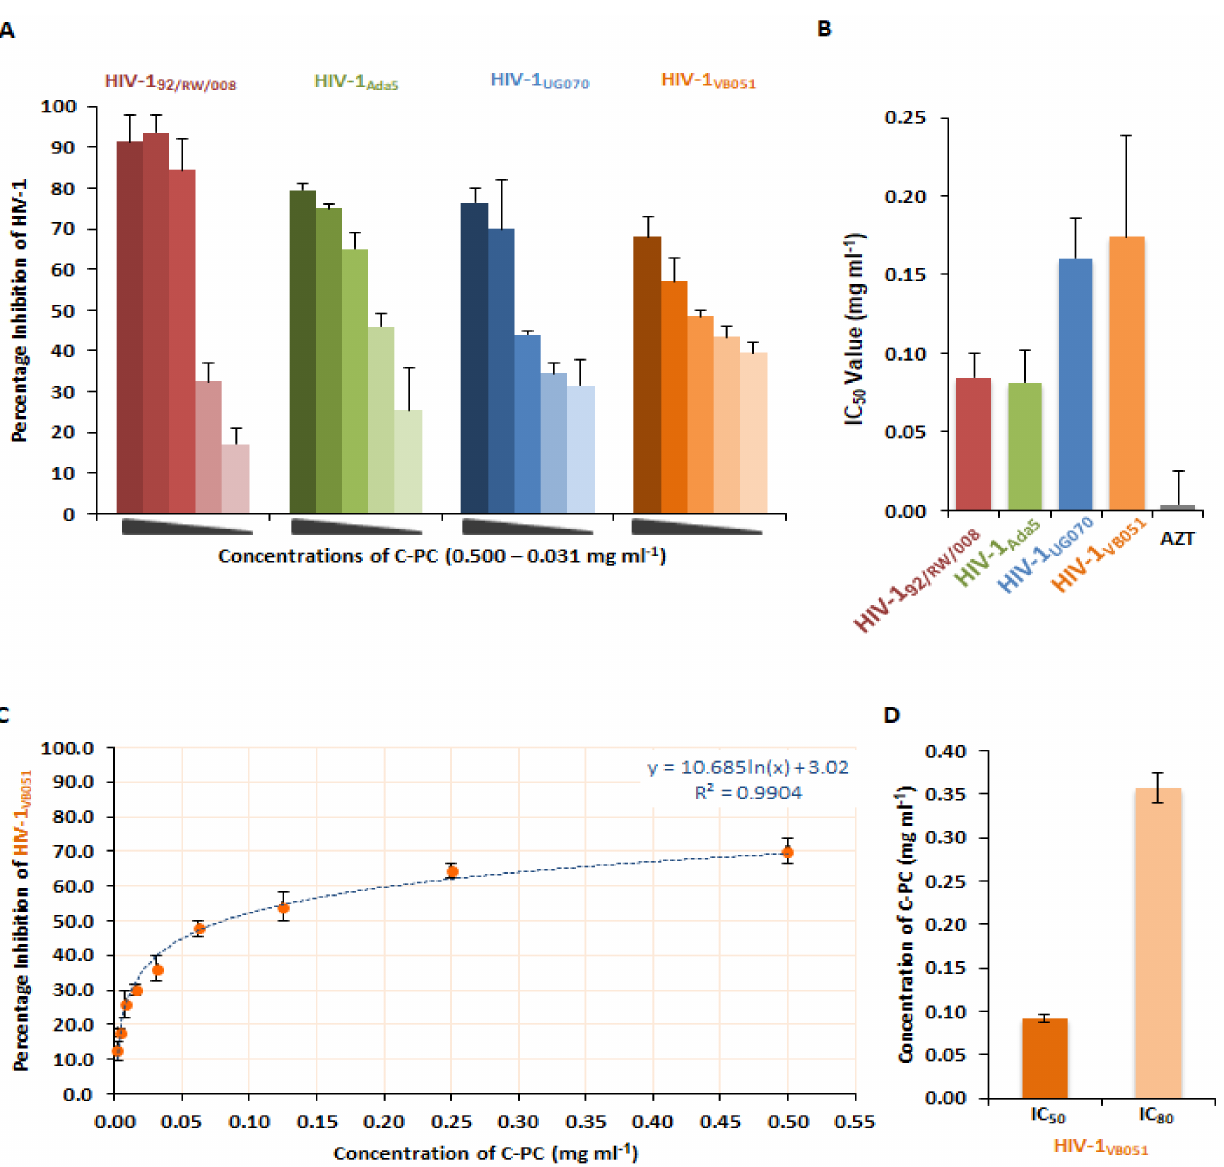
Figure 2. C-PC inhibits HIV-1 replication. ( A ) Percentage inhibition of four different subtypes of HIV-1 replication in the presence of C-PC (0.500–0.0312 mg/mL) in TZM-bl cells. ( B ) The IC 50 values for HIV-1 92/RW/008 , HIV-1 Ada5 , HIV-1 UG070 , and HIV-1 VB051 in TZM-bl. ( C ) Dose-dependent activity of C-PC in the PBMCs infected with HIV-1 VB051 . ( D ) IC 50 and IC 80 concentrations of C-PC in HIV-1-infected PBMC. Standard drug AZT was used as the positive control of HIV-1